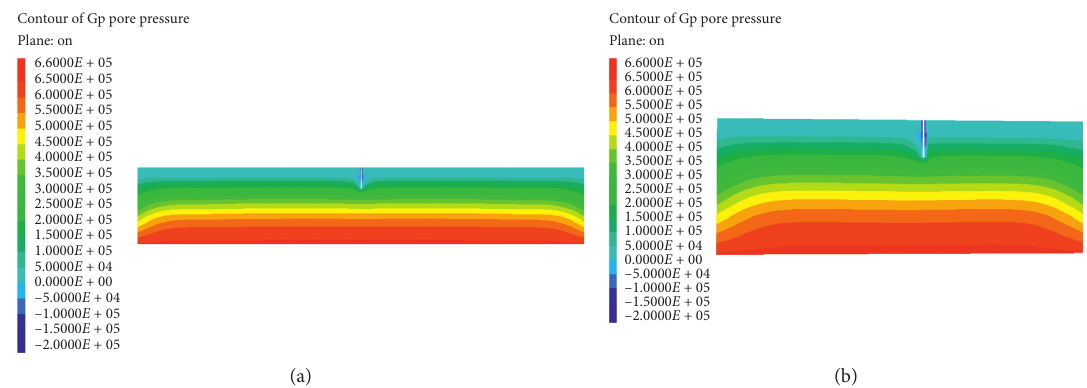
Figure 19: Single well pore water pressure nephogram after the second drawdown (unit: Pa). (a) Cross section of the well midpoint. (b) Longitudinal section of the well